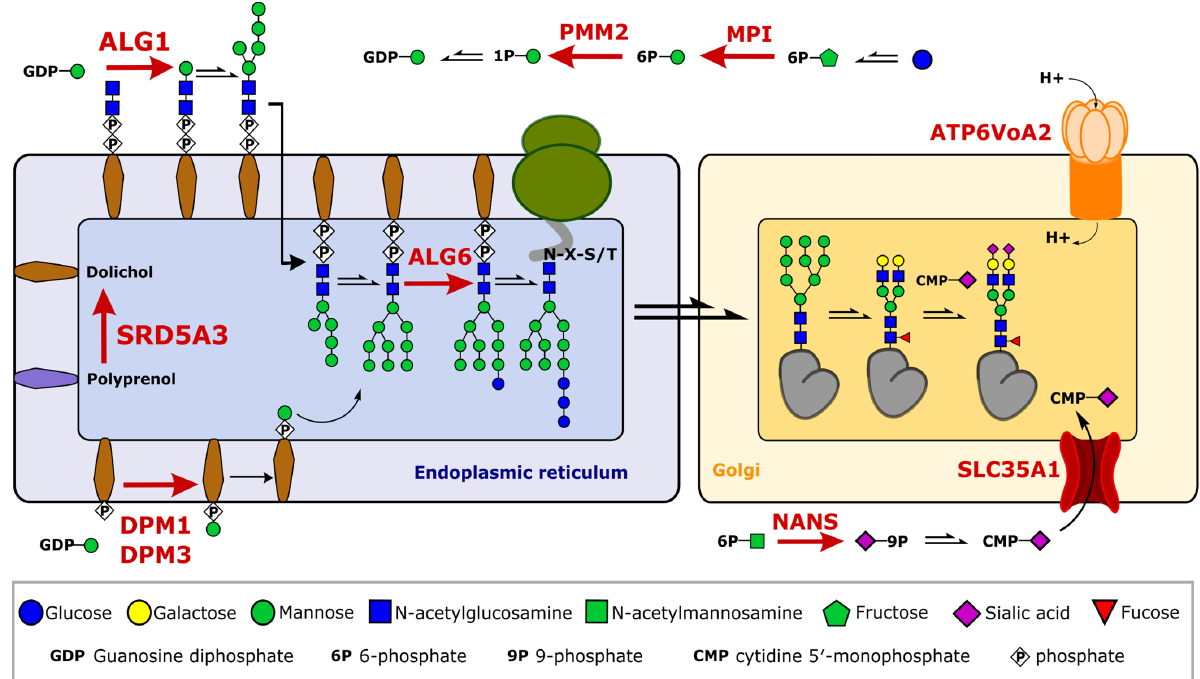
Figure 4. Simplified protein N ‐ glycosylation pathways observed in endoplasmic reticulum (ER) and Golgi. Affected genes of CDG patients and corresponding enzymatic functions are shown in red. Sugar phosphates are obtained by converting monosaccharides such as glucose to phosphorylated sugars such as mannose ‐ 1 ‐ phosphate (1P) catalyzed by enzymes such as mannose ‐ 6 ‐ phosphate isomerase (MPI) or phosphomannomutase 2 (PMM2). Nucleotide sugars such as GPD ‐ mannose or CMP ‐ sialic acid are used as glycosyl donors in protein glycosylation. Transporter proteins including SLC35A1 and changes in Golgi pH caused by genetic defects in ATP6V0A2 (ATPase H + transporting V0 subunit a2) influence protein glycosylation too.